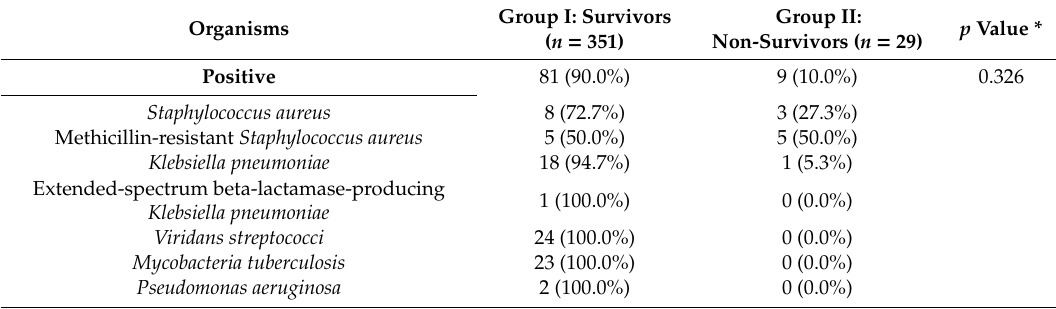
Table 2. Organisms identified from the pleural fluid.